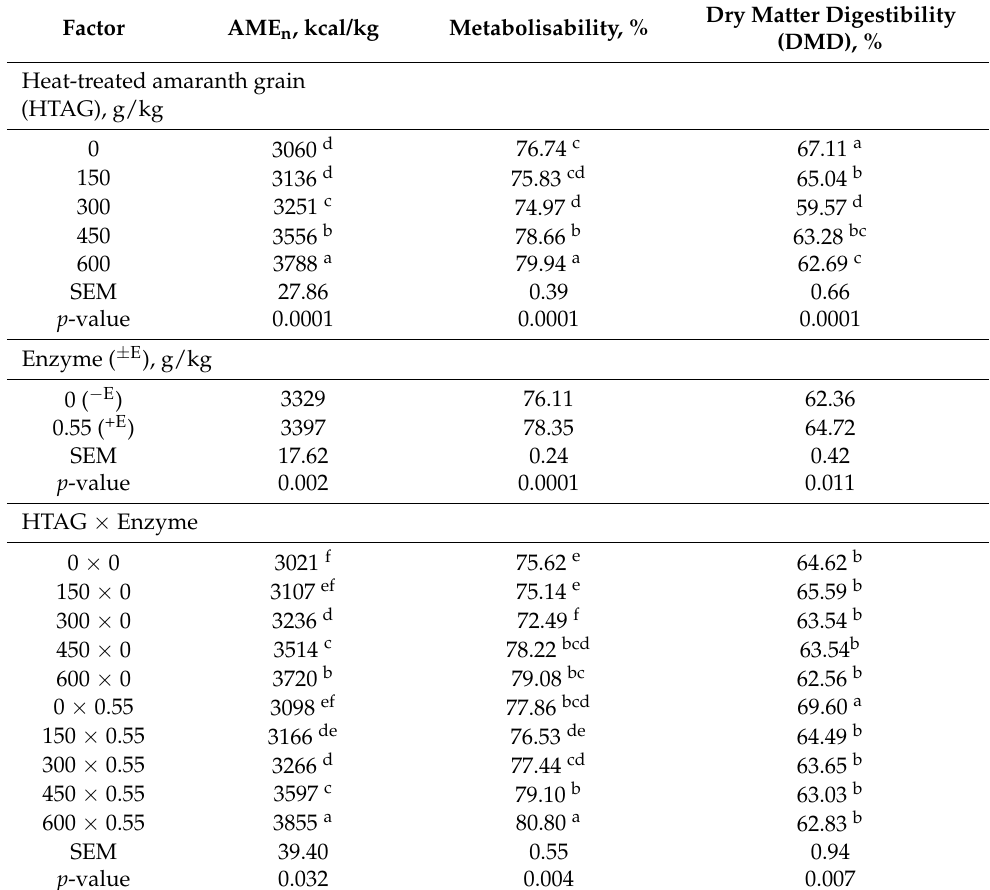
Table 4. AME n , metabolisability and dry matter digestibility (DMD) values of broiler chickens fed different levels of heat-treated amaranth grain (HTAG) with ( +E ) and without ( − E ) enzyme from 35 to 42 d of age in the first